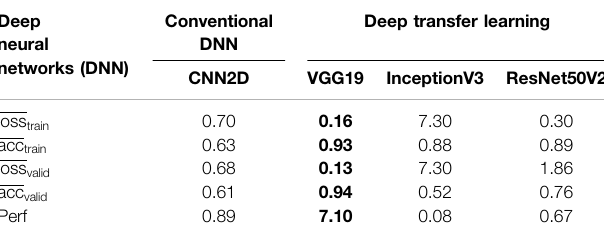
TABLE 2 | Performance evaluation of conventional deep neural networks and deep transfer neural networks. Deep neural networks